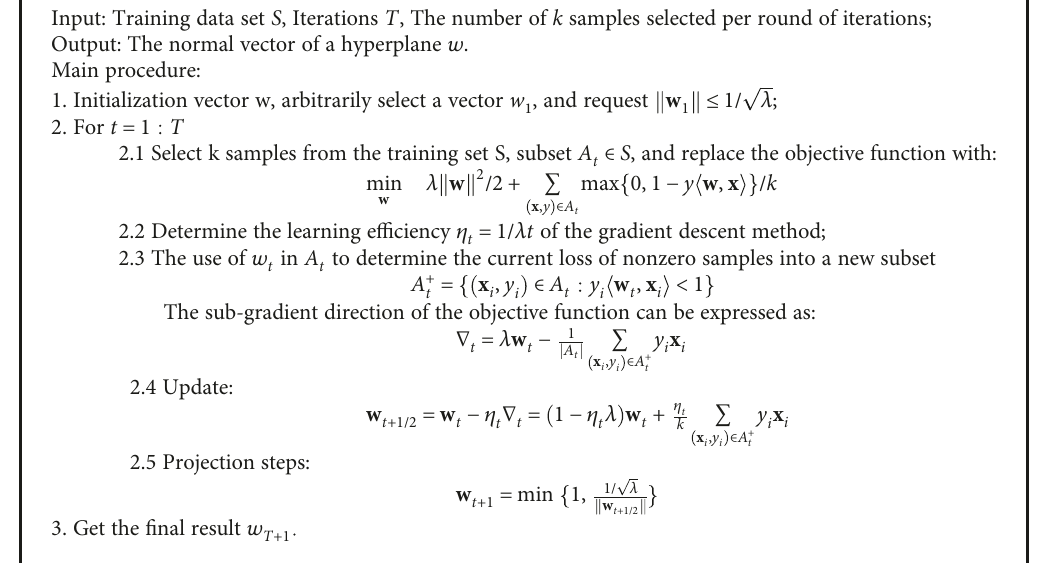
Algorithm 1: Pegasos algorithm for solving